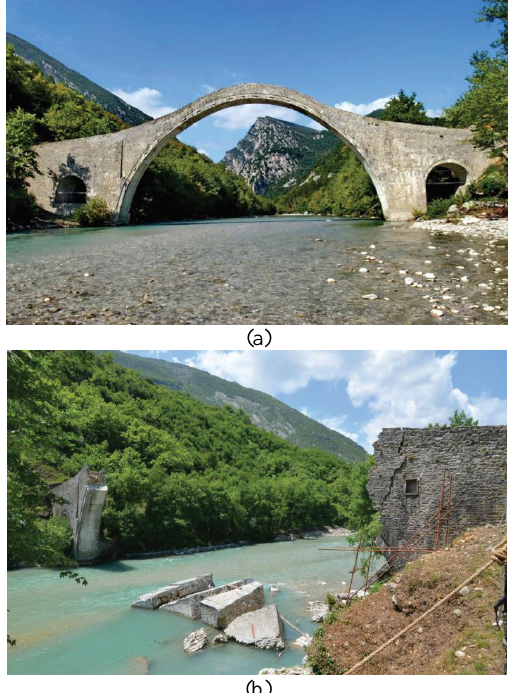
Figure 1. The bridge (a) before and (b) after the